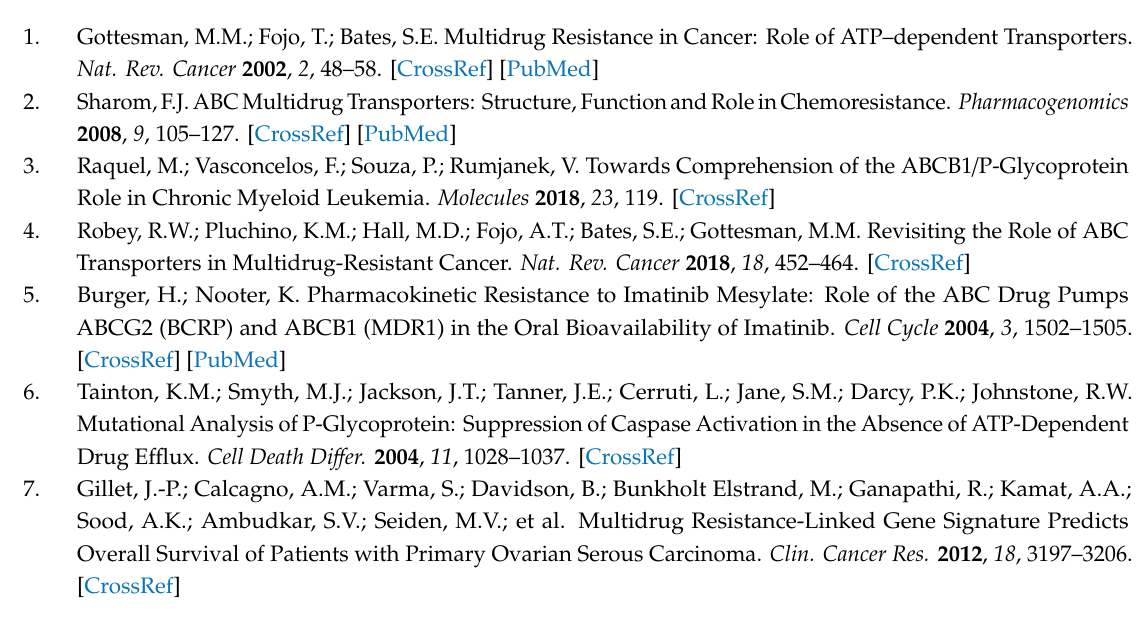
Figure S1: Analysis of parental and MDR cells viability after treatment with di ff erent drugs. Figure S2: E ffl ux activity of Pgp in cancer cell lines. Figure S3: Microparticles derived from parental and MDR cell lines. Figure S4: Analysis of Pgp e ffl ux activity by calcein-AM assay. Figure S5: Microparticles derived from parental and MDR cell